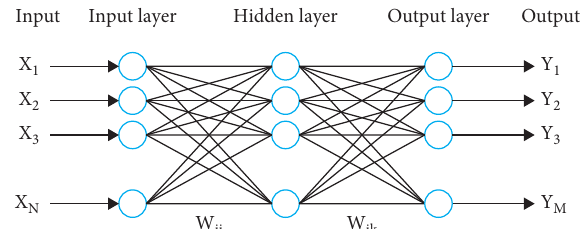
Figure 1: Schematic architecture of